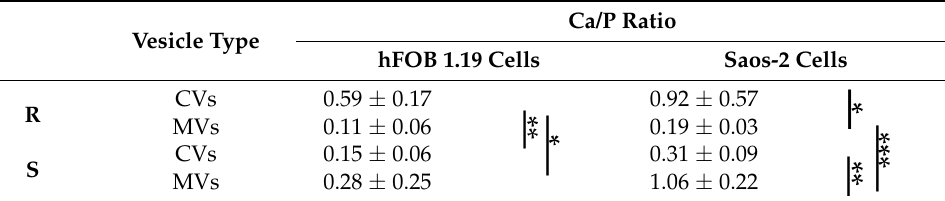
hFOB 1.19 and Saos-2 cells. The level of AnxA6 was a little higher in Saos-2 cells t than in hFOB 1.19 cells (Figure S2A,C, white), whereas the level of AnxA2 was almost two times lower in Saos-2 than in hFOB 1.19 cells (Figure S2A,C, grey). FetuA content remained at a low level (below 1.0) in resting and stimulated hFOB 1.19 cells, whereas the level was high (above 1.0) in both resting and stimulated Saos-2 cells (Figure S2C, black). TNAP (55 kDa) remained at a middle level (around 1.0) in both types of cells, and its level did not change in stimulated conditions (Figure S2A, stripped).